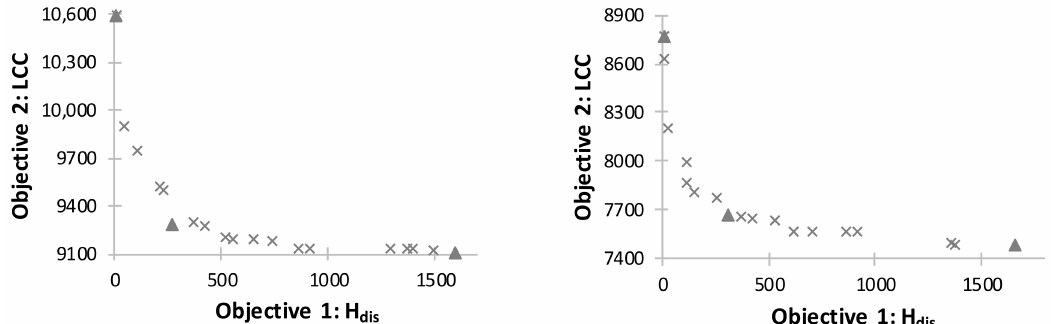
Figure 6. Pareto front for case 3 (on the left) and for case 4 (on the